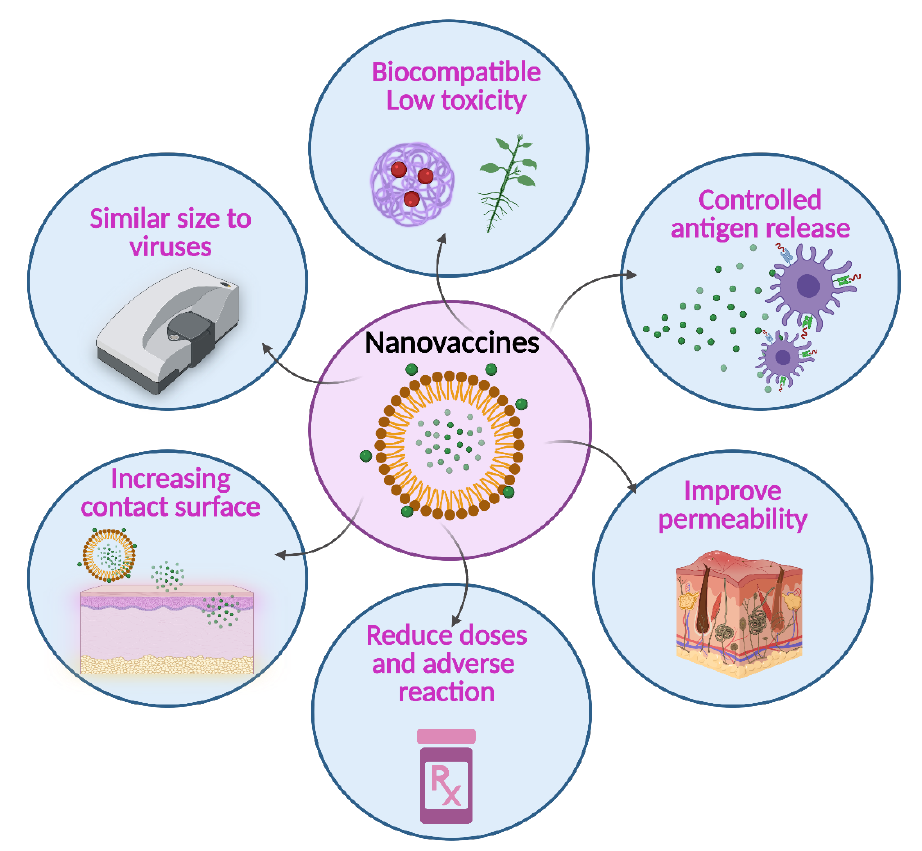
Figure 4. Main advantages of the use of nanocomposites for the delivery of antigens and the design of nanovaccines. Created with BioRender.com (accessed on 27 October 2021). Table 2. Main Nanocarriers used in transdermal